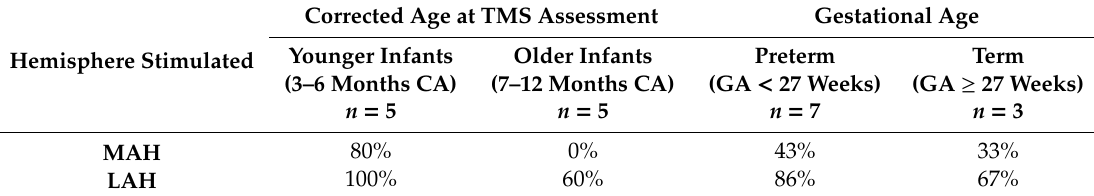
Hemisphere Stimulated